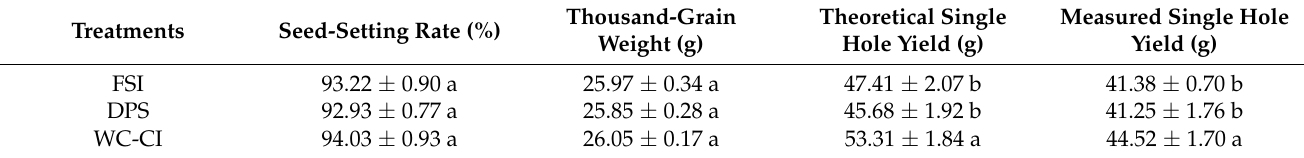
Table 5. The rice yields of different irrigation and drainage